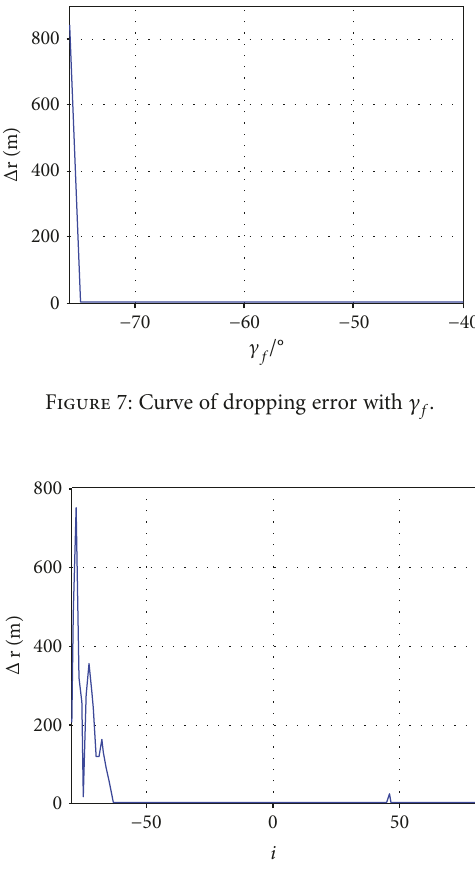
Figure 8: Curve of dropping error with i .